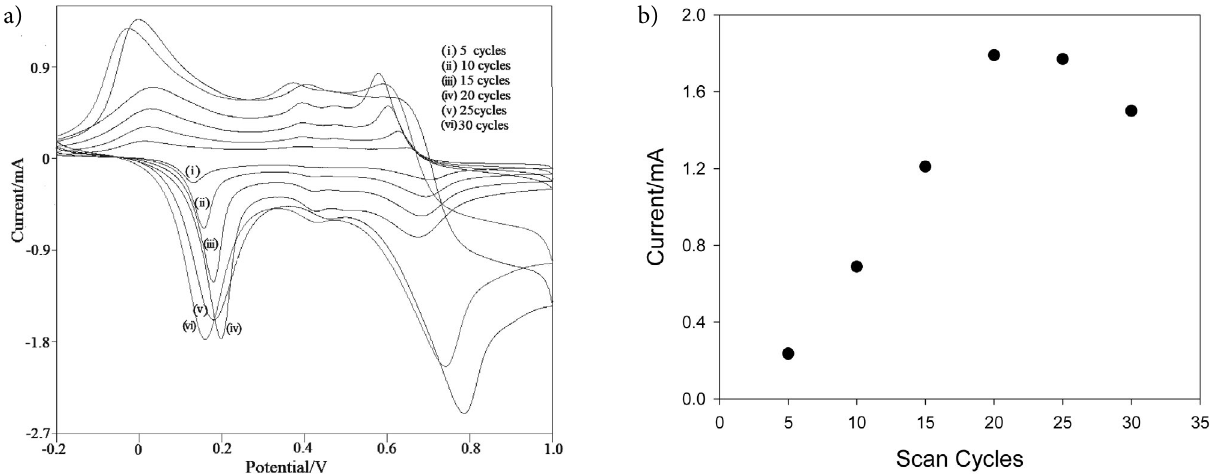
Figure 2 . (a) Cyclic voltammogram of polymerization of aniline on Pt electrode at (i) 5 cycles, (ii) 10 cycles, (iii) 15 cycles, (iv) 20 cycles, (v) 25 cycles (vi) 30 cycles. (b) Plot of anodic peak current with number of scan cycles for polymerization of